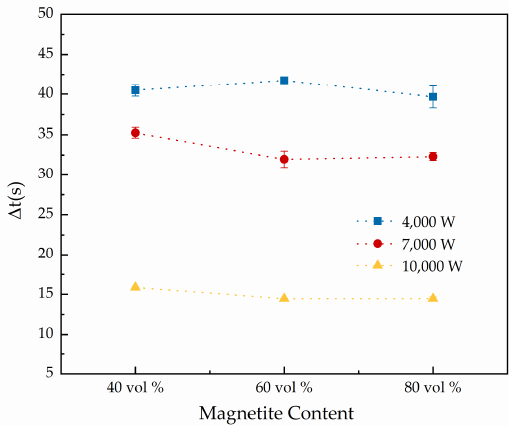
Figure 11. Experimental results of the deicing efficiency of concrete with different microwave-ab- sorbing materials content and different levels of microwave power: ( a ) sliding time t 1 (s); ( b ) time of complete ice detachment t 2 (s).